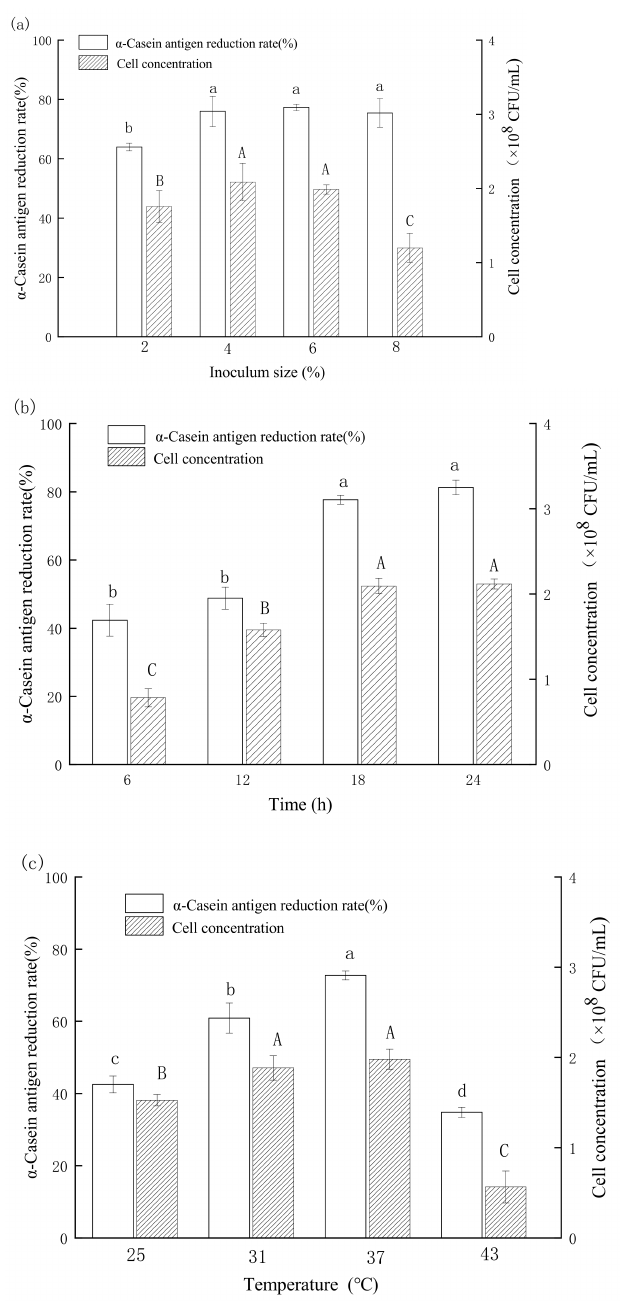
Figure 4. The effects of inoculation amount ( a ), fermentation time ( b ) and fermentation temperature ( c ) on the reduction rate of α -casein antigen and cell concentration of fermented milk. Bars with lowercase letter are significantly different for α -case in antigen reduction rate ( p < 0.05) ( n = 3). Bars with capital letter are significantly different for cell concentration ( p < 0.05) ( n =